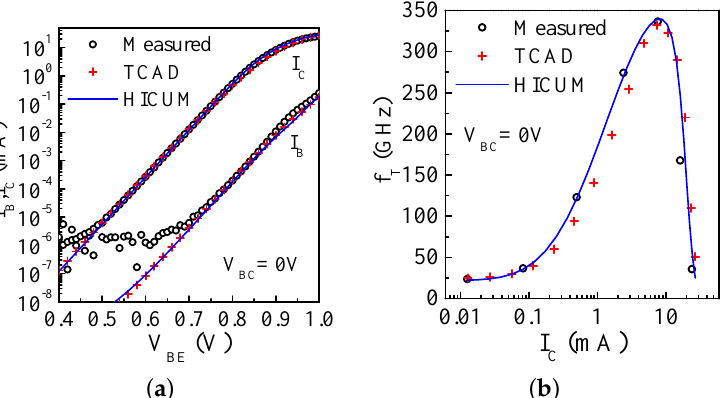
Figure 3. ( a ) Gummel plots and ( b ) collector current dependent transit frequency characteristics for a 0.09 µ m × 4.8 µ m SiGe HBT biased at V BC = 0 V and V BE varying from 0.4 V to 1 V: comparison between measured data (“o” symbol), calibrated TCAD simulation (“+” symbol) and quasi-static HICUM model (solid